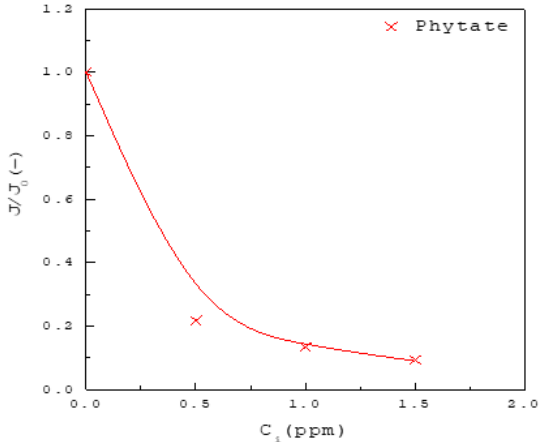
Figure 6. The decrease of J with increasing inhibitor concentration for the solutions in the presence of phytate for S = 13.65 at 37 ◦ C. The solid line is a visual guide.